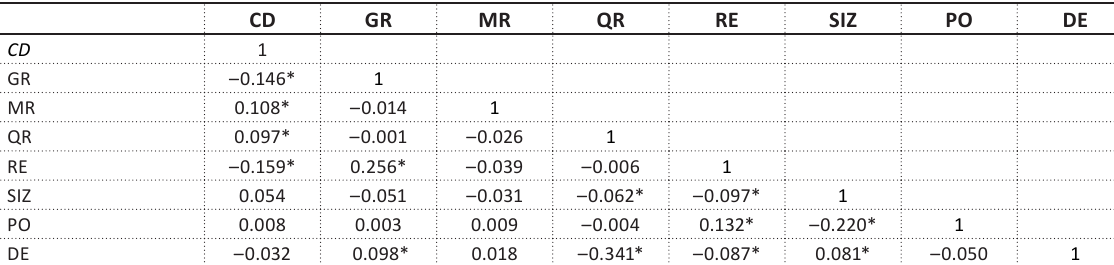
Table 2. Correlation matrix